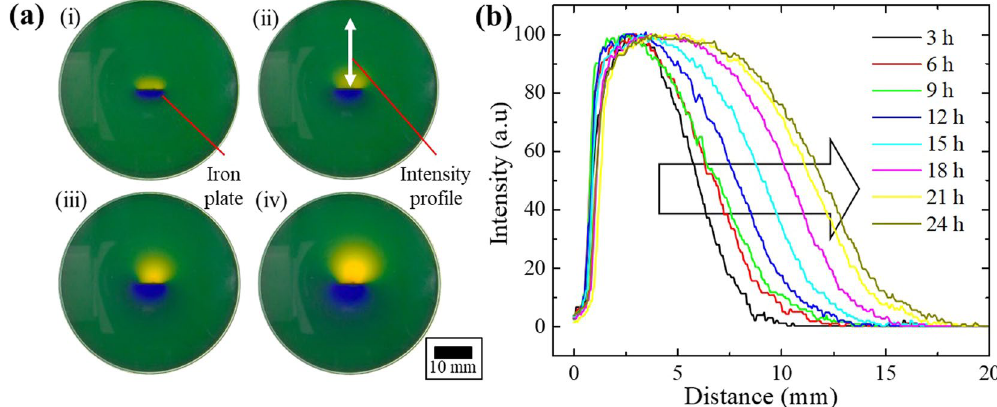
Figure 4. ( a ) Image of BTB agar gel with Fe plate inserted for 24 hours (i) 0.5 hours (ii) 3 hours (iii) 12 hours (iv) 24 hours. (b) The colour intensity spectra for 3–24 hours.